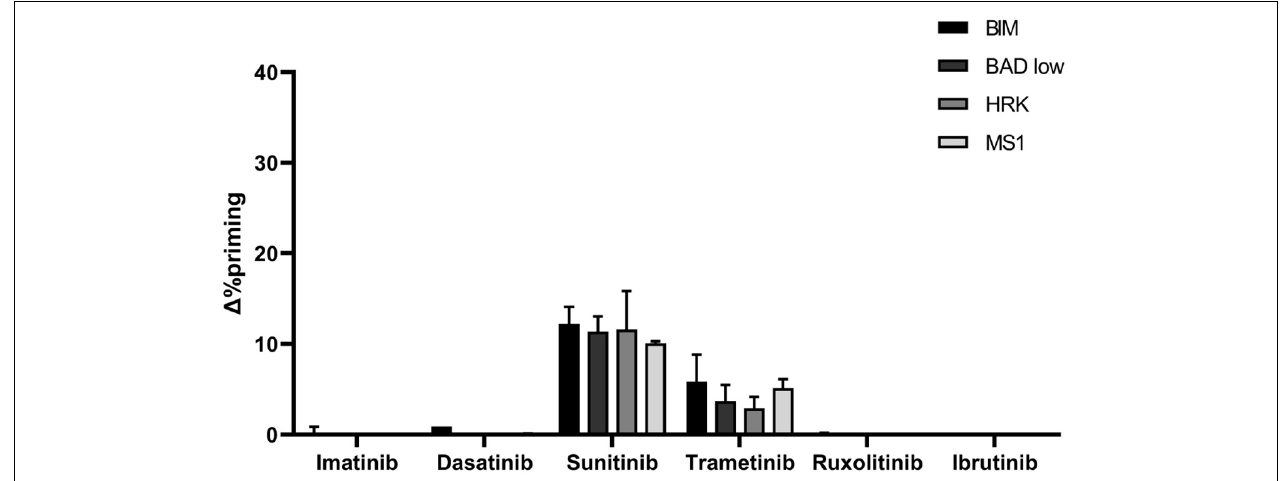
FIGURE 7 | PDX cells presenting KMT2A rearrangement show a similar DBP profile as the SEM cells. DBP with BIM BH3, BAD BH3, HRK BH3, and NOXA BH3 peptides after 16 h of incubation with 1,000 nM imatinib, 100 nM dasatinib, 1,000 nM sunitinib, 100 nM trametinib, 100 nM ruxolitinib and 1,000 nM ibrutinib in PDX cells. (cid:49) %priming stands for the difference in %priming between treatment and control condition. All results are expressed as the mean ± standard deviation of two technical